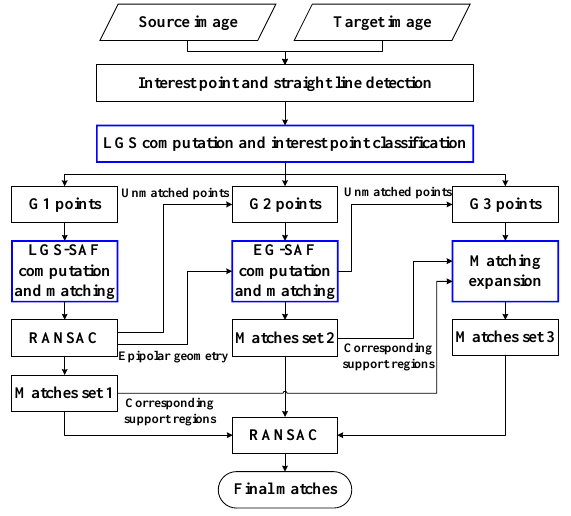
Figure 2. Workflow of the proposed matching method. The blue boxed steps are the key steps of our workflow.